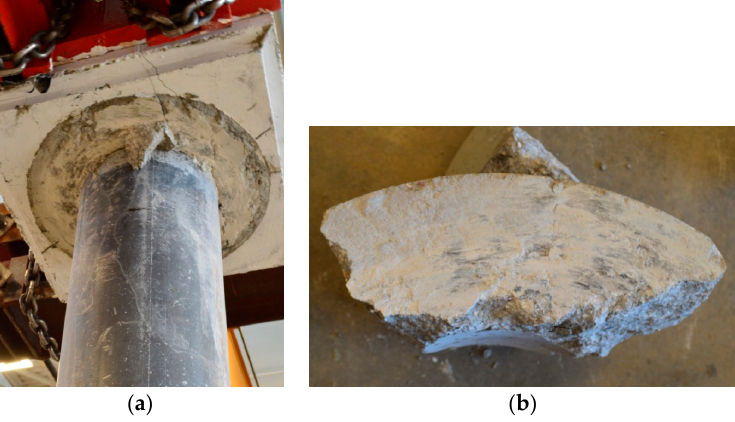
Figure 7. Grinding of concrete surfaces at: ( a ) loading head, ( b ) concrete shell.